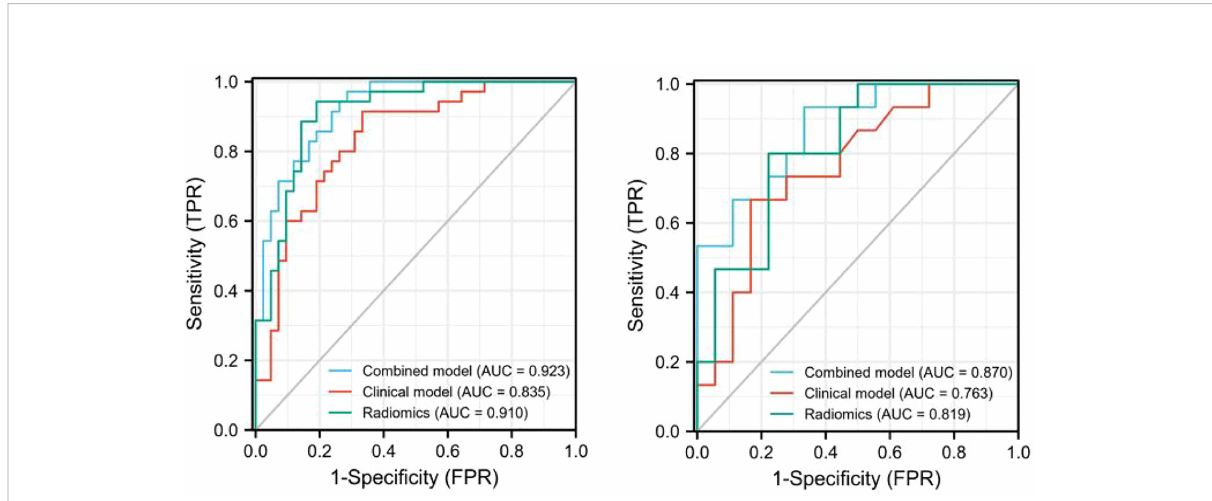
FIGURE 7 The AUC values for combined radiomics nomogram, clinical and radiomics were used to differentiate between low-risk and high-risk thymomas (Left, training set; right, validation set).